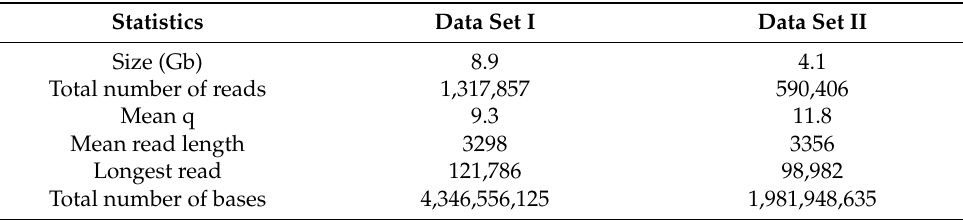
Table 2. Statistical parameters of Data set I and II obtained with NanoPlot.